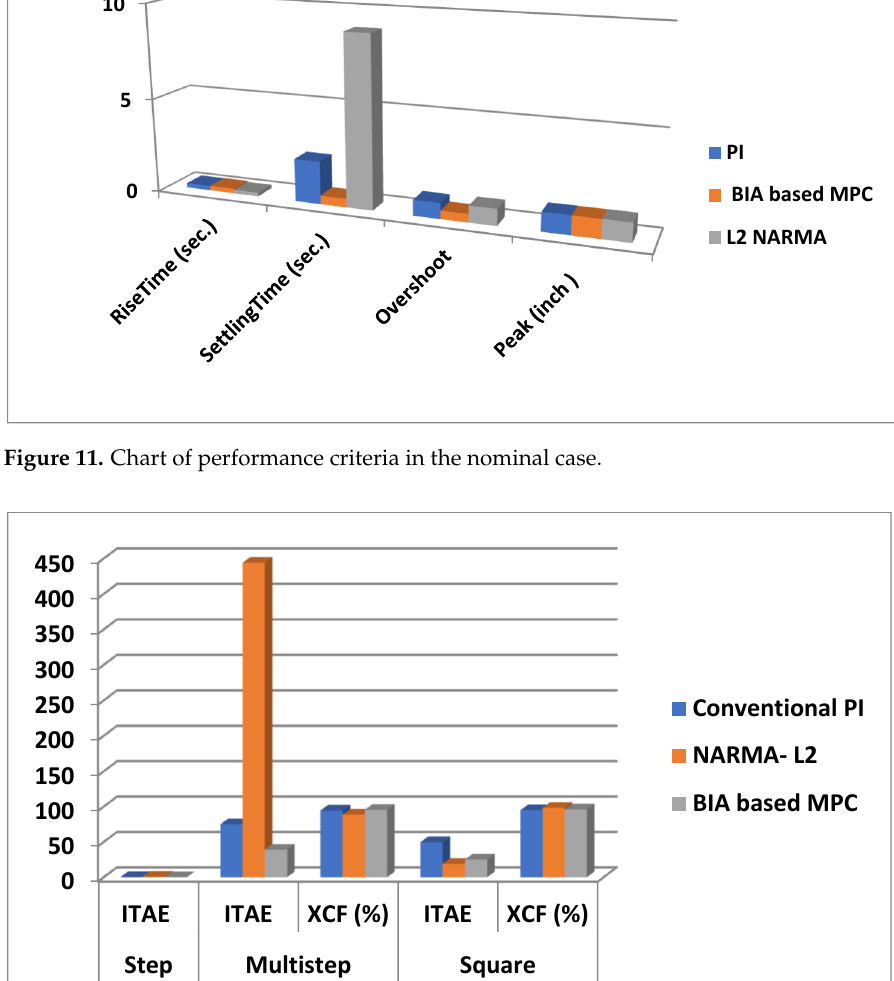
Figure 12. Chart of ITAE and XCF in the nominal case.